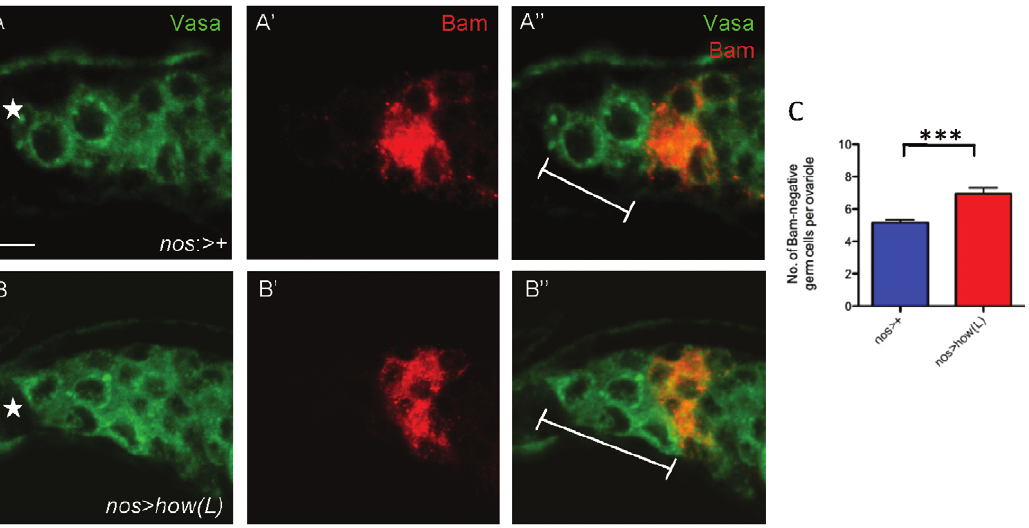
Figure 5. Overexpression of HOW(L) delays the expression of Bam. Comparison of the onset of Bam accumulation in ovaries. ( A ) In control ovaries (nos: Gal4), 2–3 GSCs reside at the anterior position of the germarium. Bam (red) is first detectable in 2-cell cystocytes. Therefore, GSCs and cystoblasts are Bam-negative in the region anterior to Bam expression (white line) in wild type germaria. ( B ) Overexpression of HOW(L) in the female germline ( nos . how(L) ) results in more early germ cells in the region anterior to Bam expression. ( C ) Statistical analysis showing the number of early germ cells in nos . how(L) germaria is greater than nos :Gal4 ovarioles (p , 0.0001). Anterior marked (*). Scale bar 5 m m.